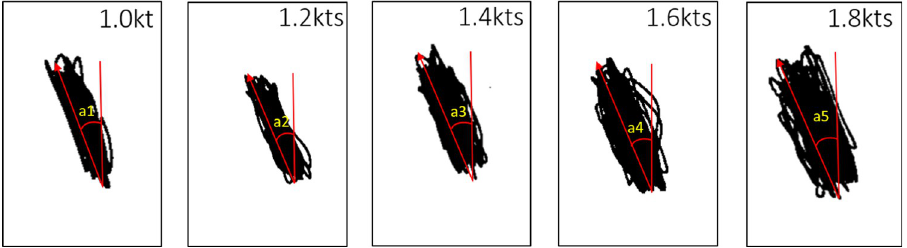
Fig 3. Movement of the shaking codend across five flow velocities from 1.0 to 1.8 kt. Black lines track codend movement angles (a1-a5) across 5 flow velocities, 1.0 kt, 1.2 kt, 1.4 kt, 1.6 kt, and 1.8 kt.